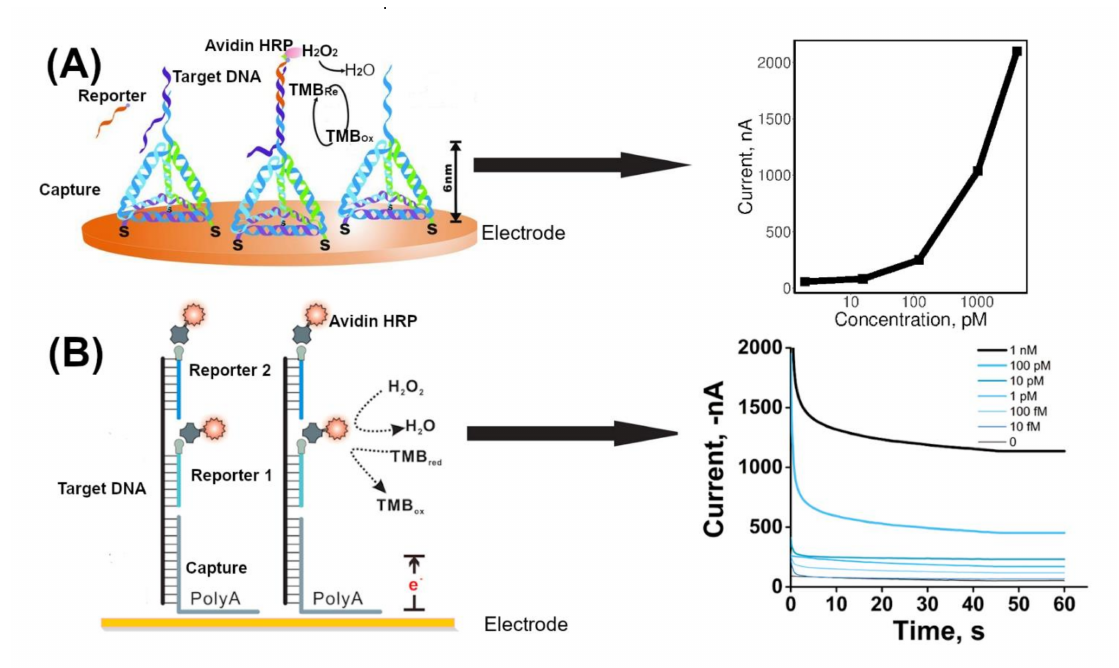
Figure 2. Schematic presentation of an HRP amplified electrochemical signal for DNA detection yth of enzyme molecules for the electrochemical signal. ( A ) DNA tetrahedral nanostructure for enhanced signal detection on gold surfaces [71]. ( B ) PolyA–gold surface interaction for immobilization of capture DNA, which was combined with multiple reporter probes and was attached to multiple HRP enzyme copies for signal amplification [50]. Adapted with permission from cited